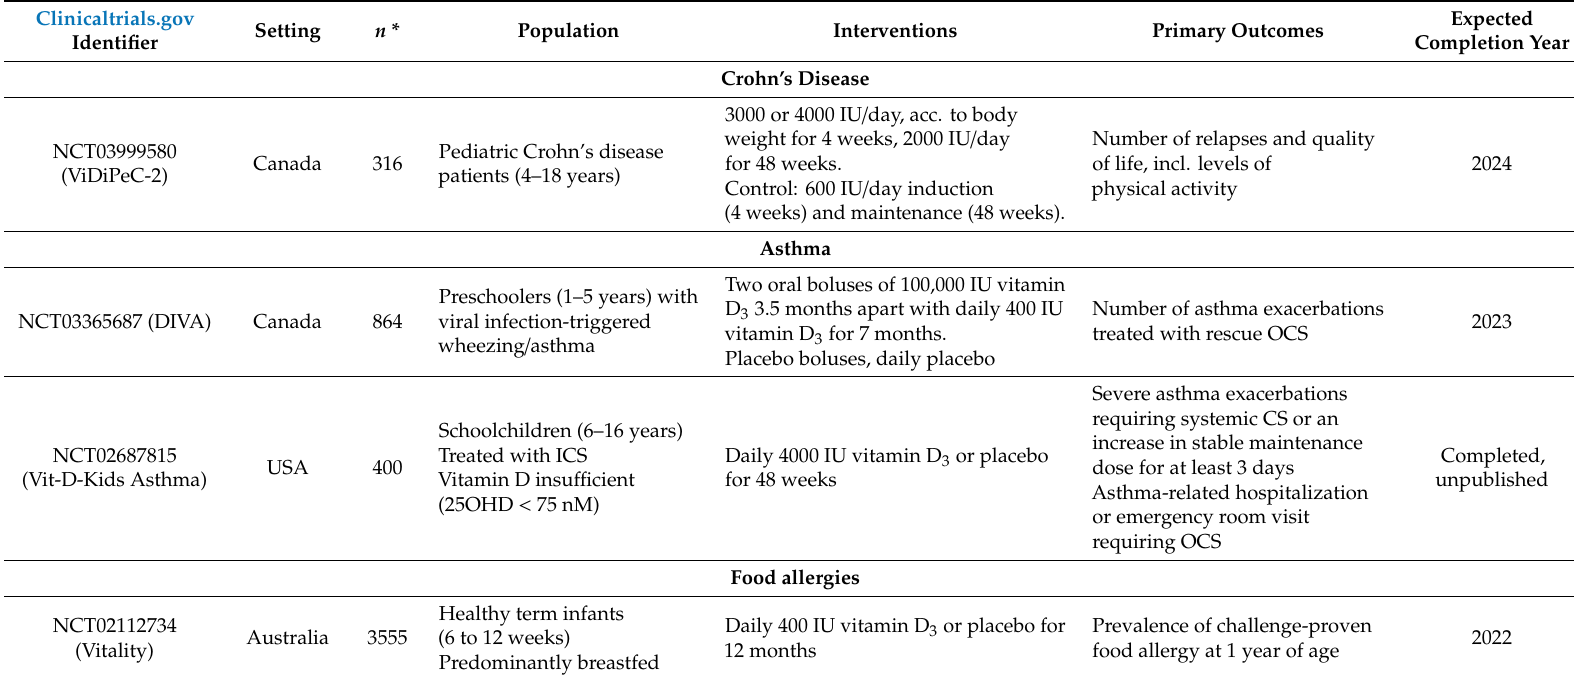
Table 1. Unpublished randomized controlled trials on the e ff ect of vitamin D in pediatric immune conditions. Clinicaltrials.gov